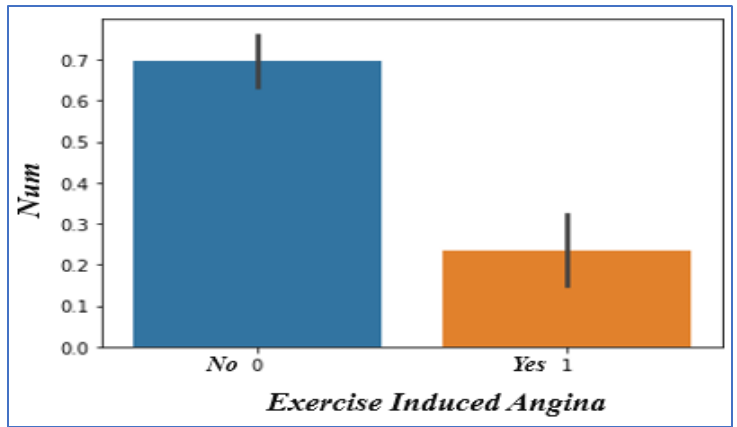
Figure 9. Exercise-Induced Angina vs. disease chances.